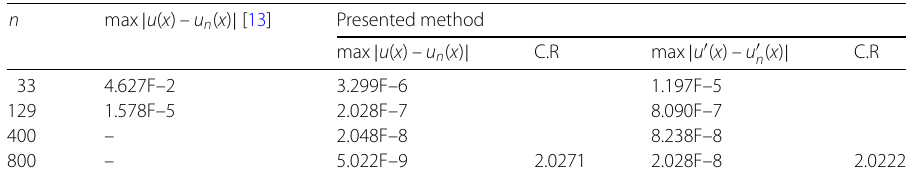
Table 2 Comparison of absolute errors in Example